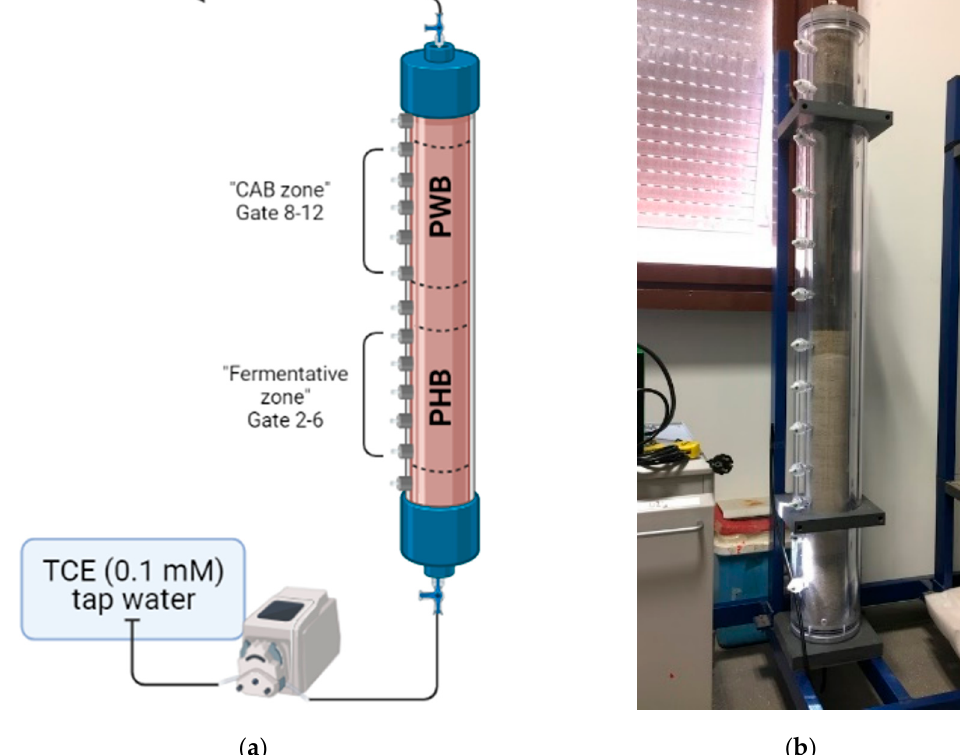
Figure 3. ( a ) Schematic setup; ( b ) a photograph of the Polyhydroxybutyrate (PHB)-biochar reactor.